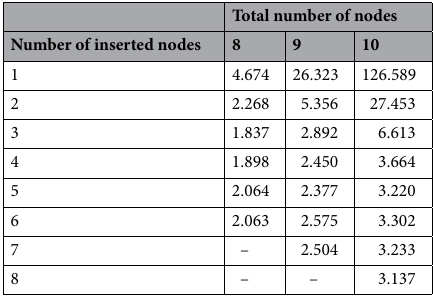
Select an arbitrary target point from the remaining m- 1 target points, insert it into the two target points of the optimal path sequence obtained by Step2, and use the improved A* algorithm to solve for the optimal path in the current case among the n-m + 2 possible path sequences. Step 4: By analogy, until all m target points are selected, the path sequence obtained is optimal. Step 5: Determine whether to traverse all target nodes. If yes, end the operation. Otherwise, repeat the above steps.